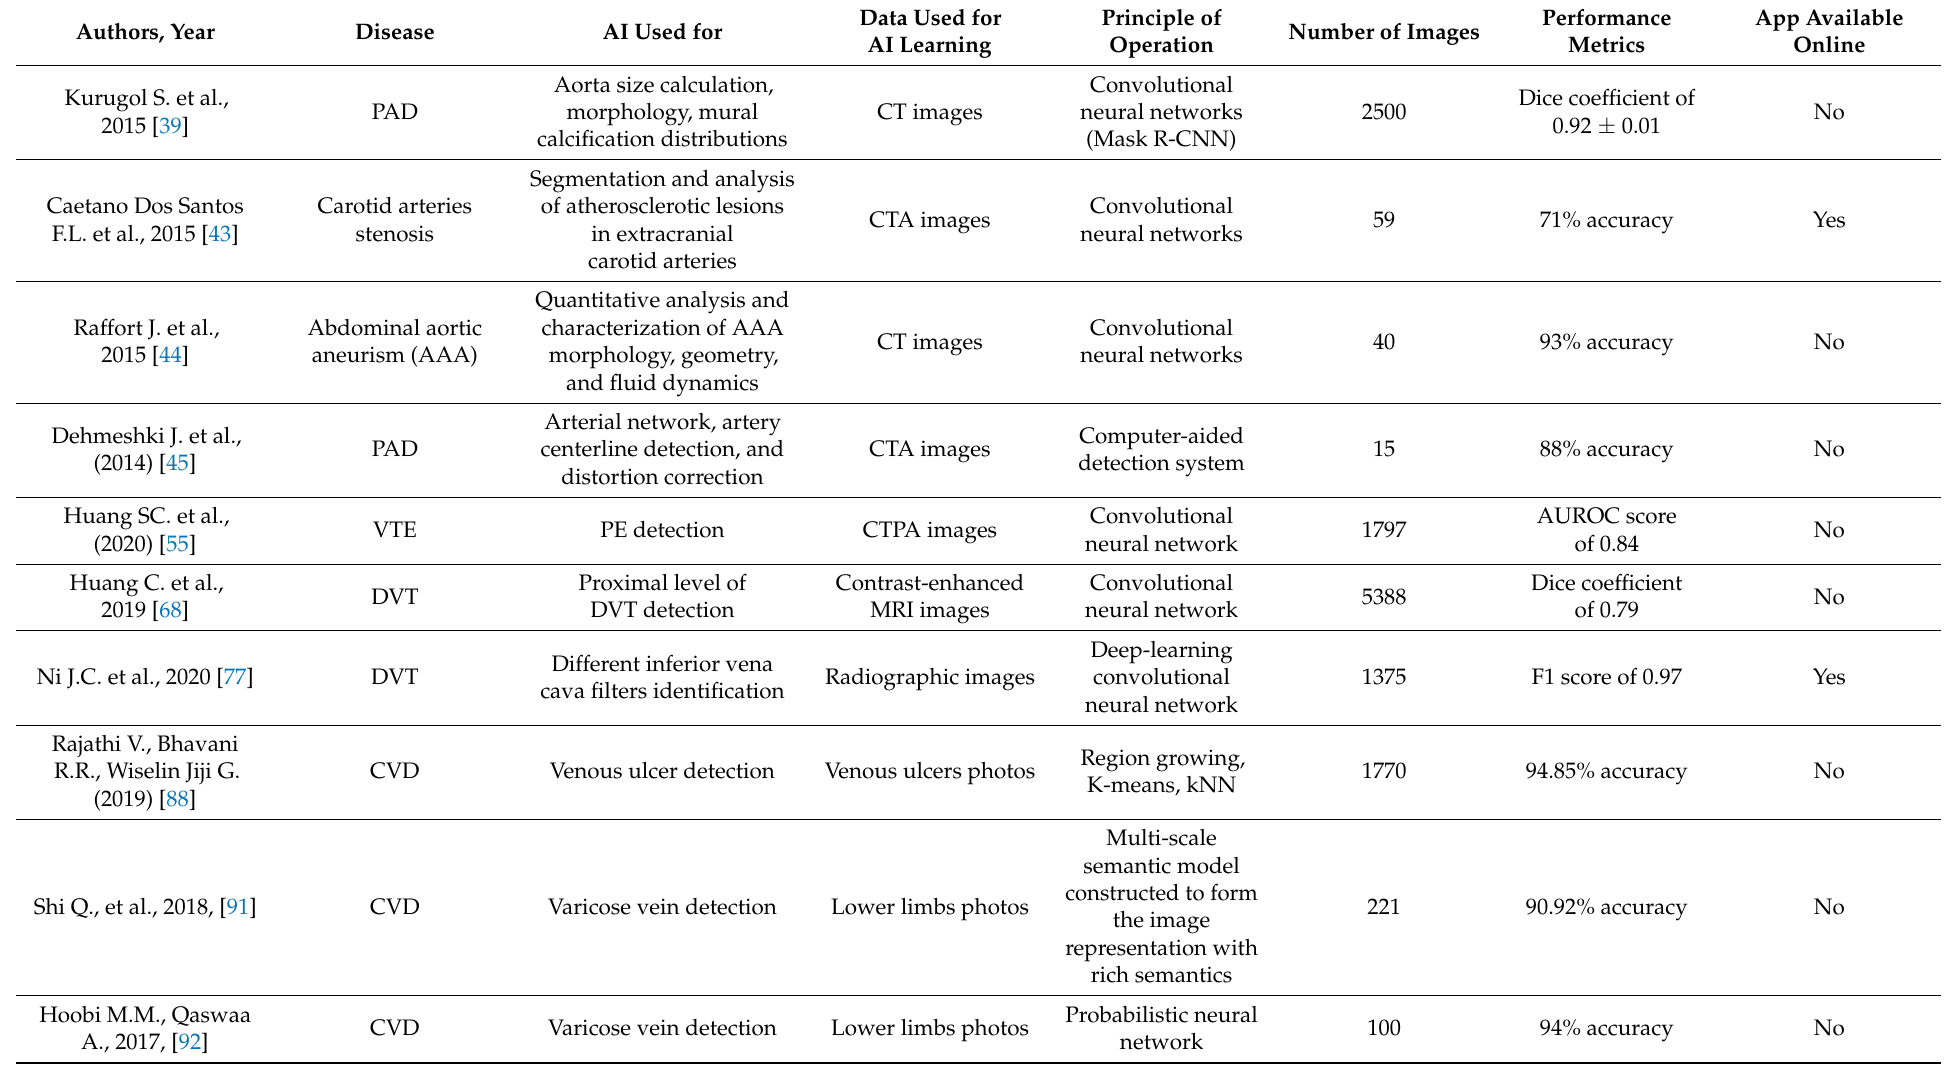
Table 1. AI tools based on learning with